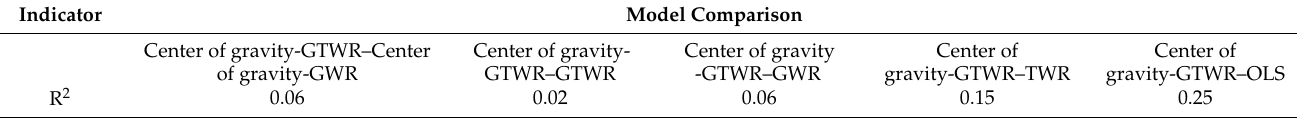
Table 6. Model comparison assessment of the center of gravity-GTWR model.